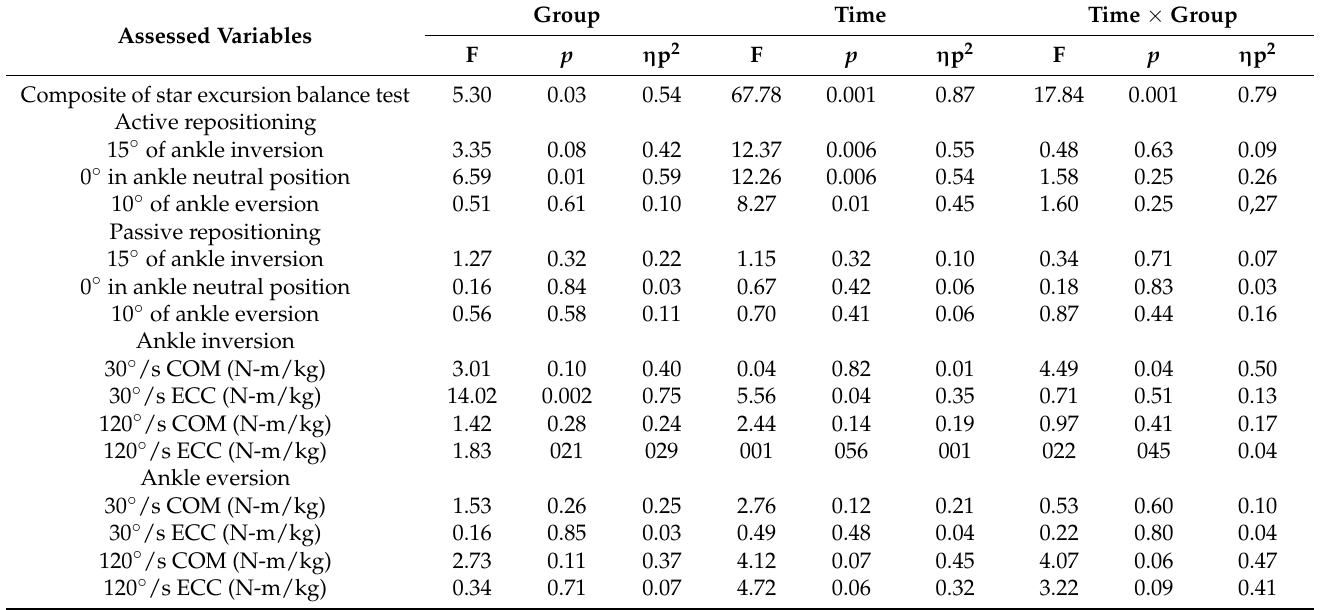
Table 2. Outcome of ANOVA with the factors for the assessed variables.